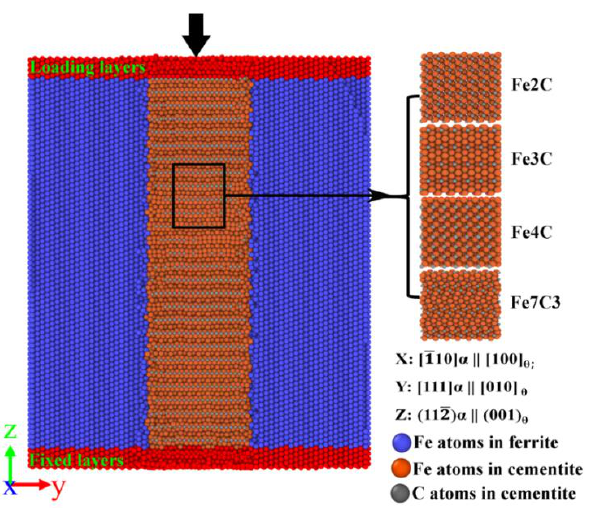
Figure 1. Initial model of the ferrite–carbide structure with various types of